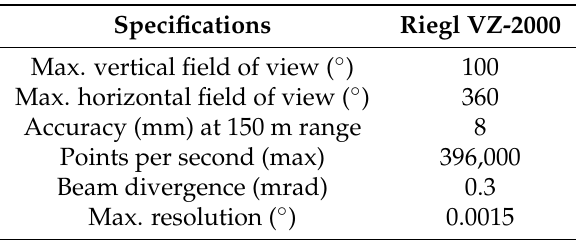
Table 1. Specifications of the Riegl VZ-2000